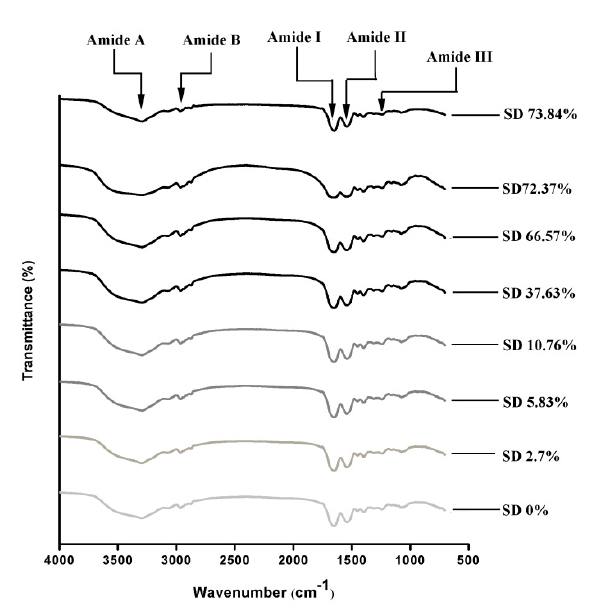
Figure 4. Fourier Transform Infrared (FTIR) spectra of samples of EWP (0%) and SEWP with various succinylation degrees (2.7%, 5.83%, 10.76%, 37.63%, 66.57%, 72.37%, and 73.84%).